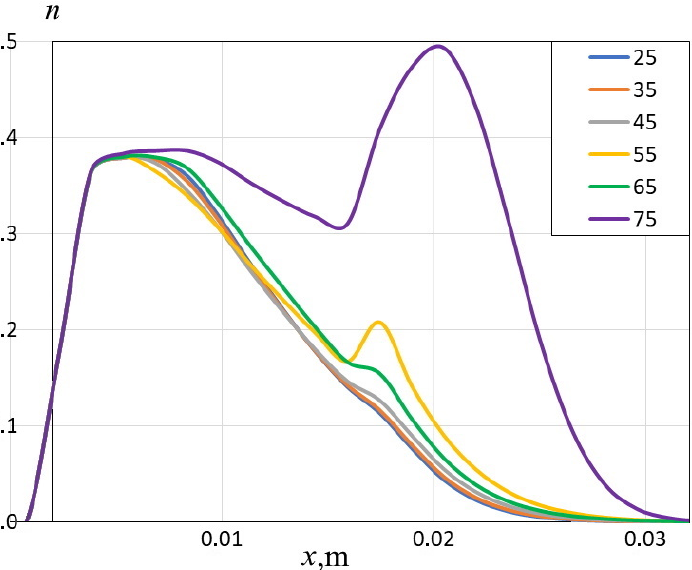
Figure 13. Vapor fraction n along the nozzle of Venturi tube type at different temperatures (temperature is shown in °C) (from our CFD results).